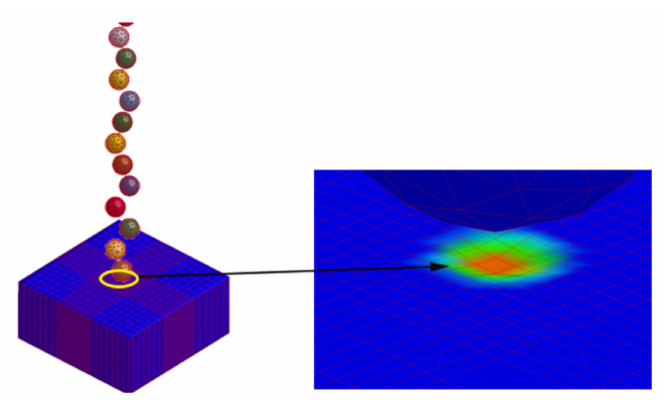
Figure 1. FEM model of multi-projectile impacts and partial enlarged diagram.